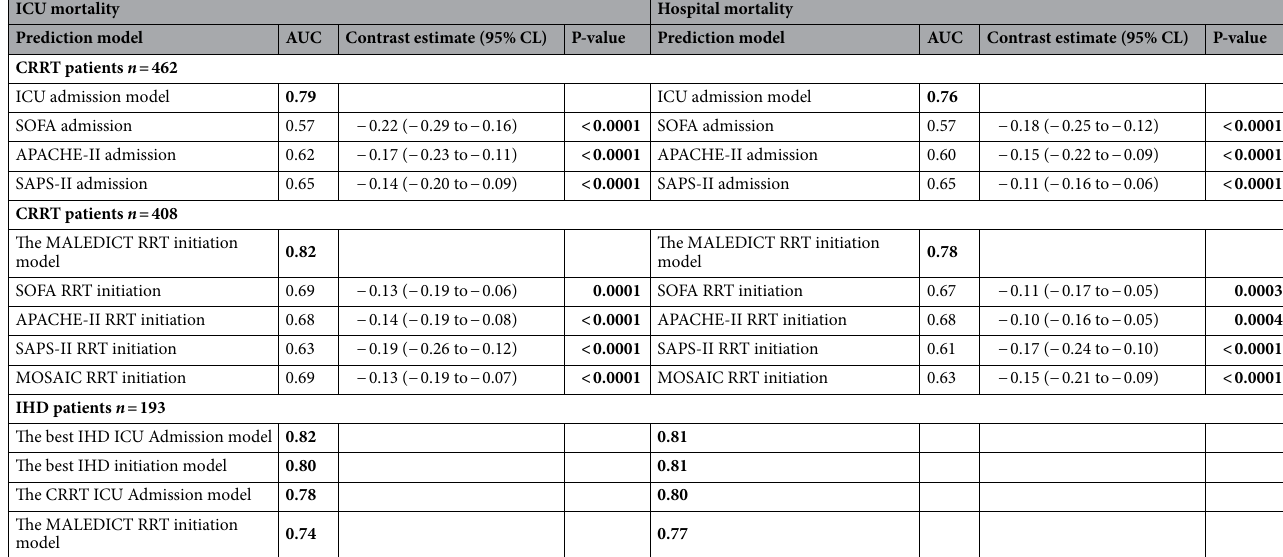
Table 3. Comparisons between the predictive power of the new developed risk estimate models versus APACHE-II, SAPS-II, SOFA and MOSAIC scores in the complete case CRRT population. Values for the ICU admission and RRT initiation models and comparisons between prediction models are mean values for 25 multiple imputations. CL confidence limit, ICU intensive care unit, SOFA-score Sequential Organ Failure Assessment score, APACHE Acute Physiology and Chronic Health Evaluation II score, SAPS Simplified Acute Physiology II score, CRRT continuous renal replacement therapy, RRT renal replacement therapy. Significant values are in bold.